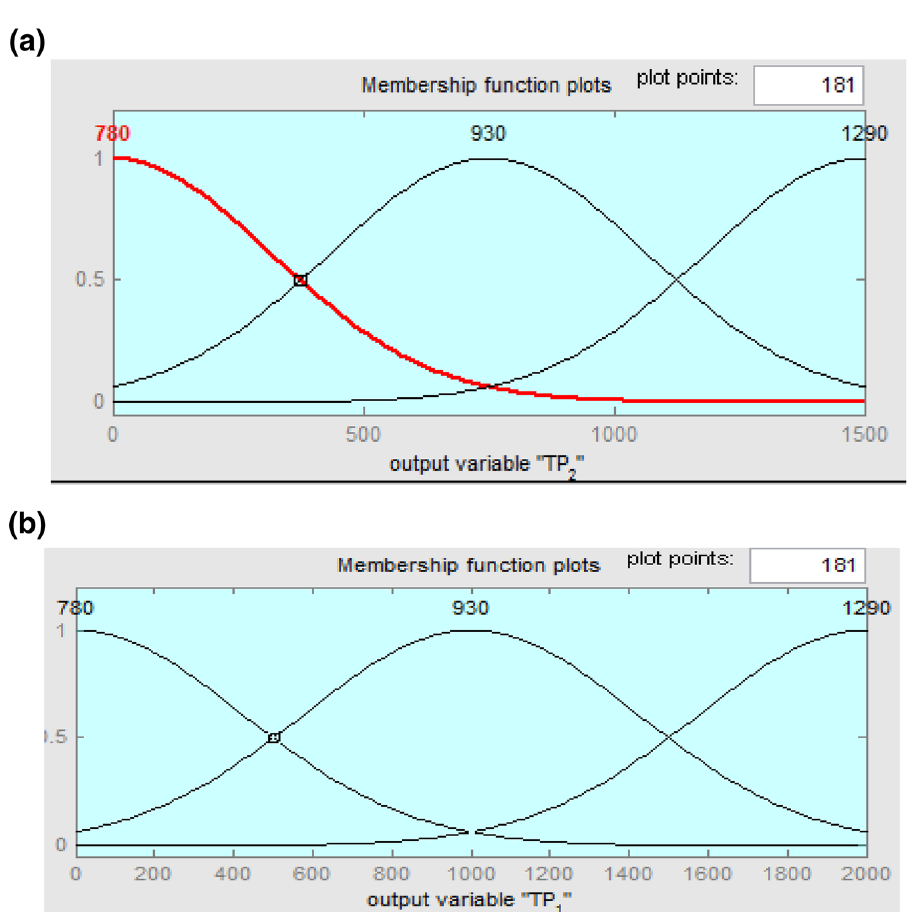
Fig. 2 a, b Membership func- tion plot for output